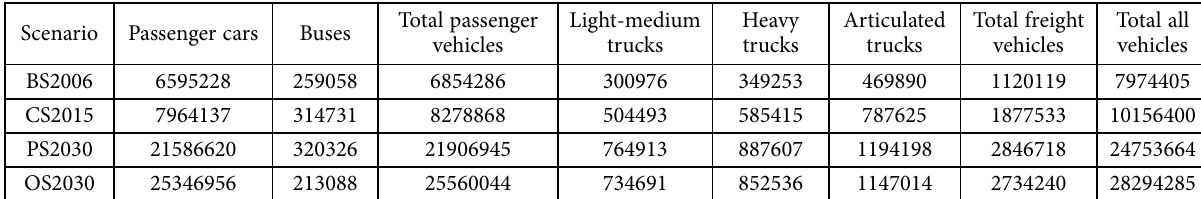
Table 3. Transport demands on the road network according to various scenarios [×1000 veh-kms]